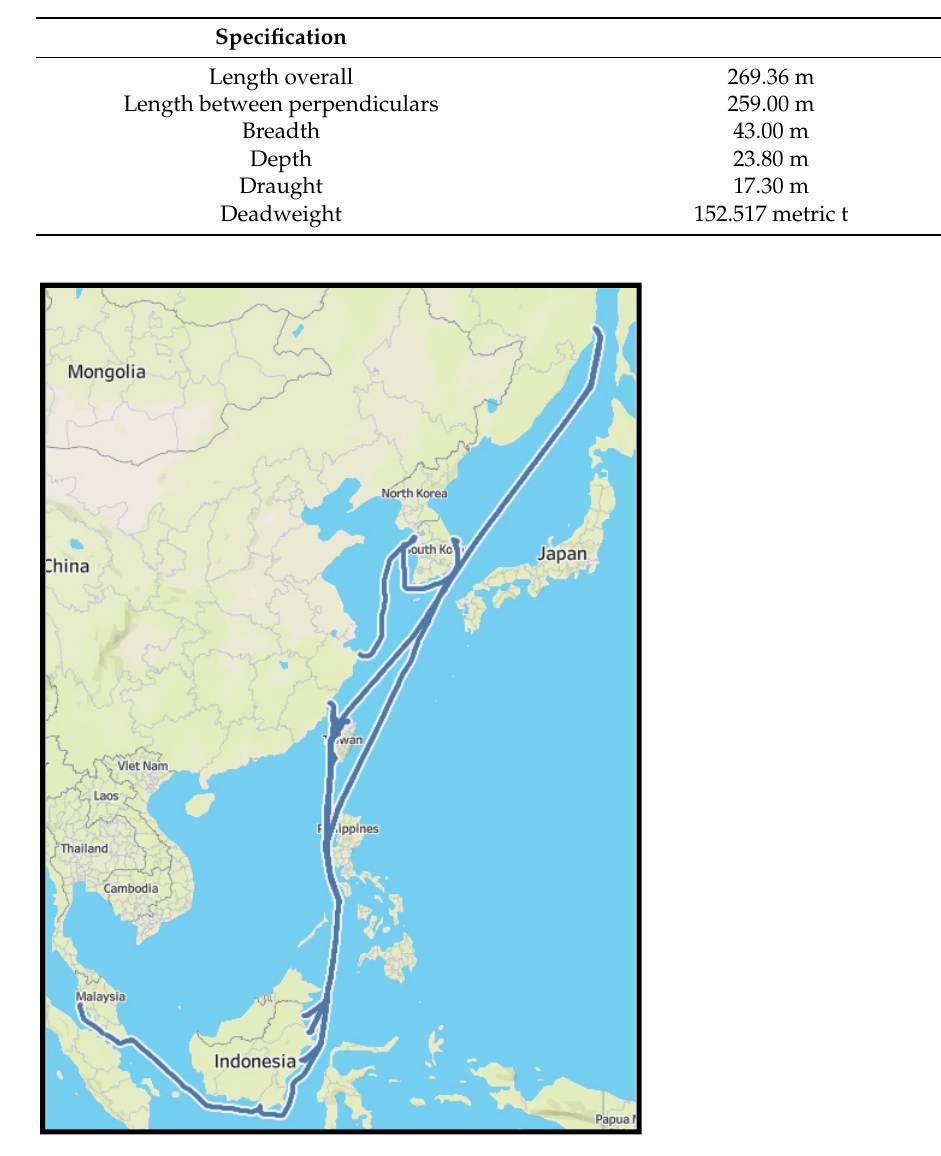
Table 1. Vessel specification.